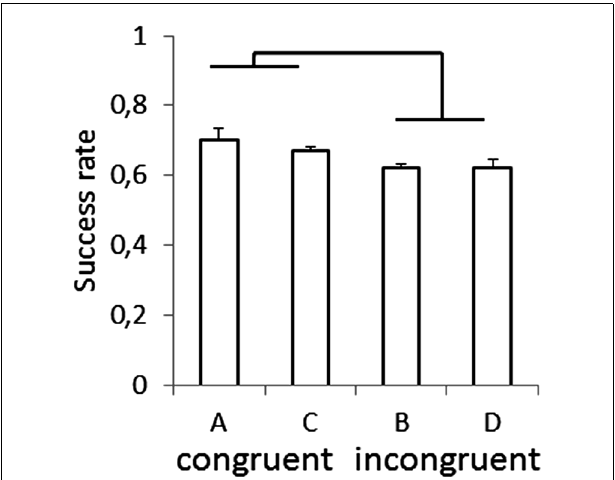
FIGURE 3 | Success rate for each type of scene in the manipulation of visual congruence between background and gravity orientation. Brackets indicate that success rate was significantly ( p < 0.05) higher for the congruent scenes (A,C in Figure 2 ) than for the incongruent ones (B,D). Modified with permission from Zago etal. (2011b).